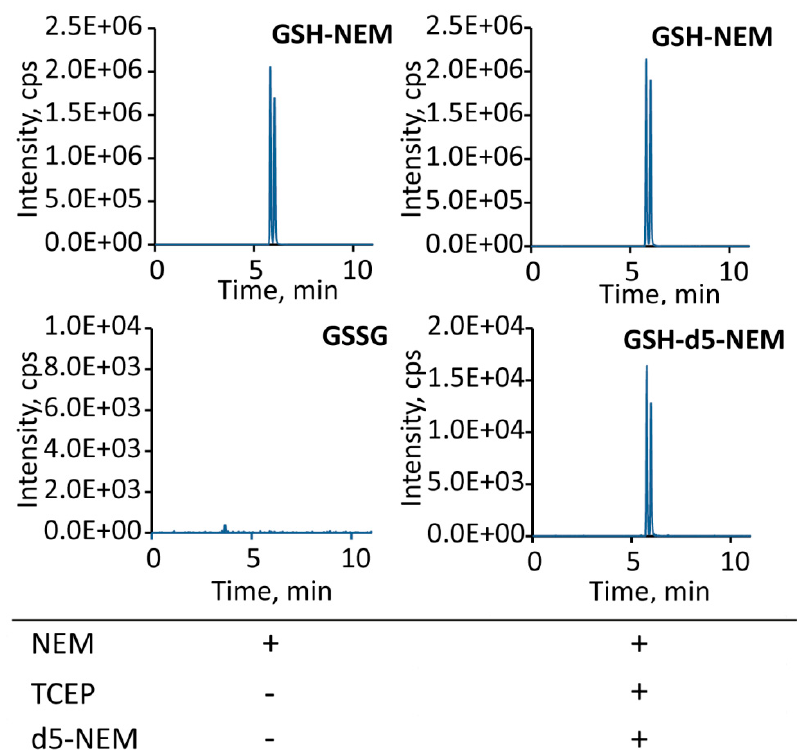
Figure 5. Detection of GSSG in minimal amounts of whole blood. In 1 µL of whole blood, no quantifiable GSSG peak was directly detectable (left), while reduction of GSSG with Tris(2-carboxyethyl)phosphine (TCEP) to GSH and subsequent alkylation with d5-NEM resulted in clearly detectable GSH-d 5 -NEM (right).